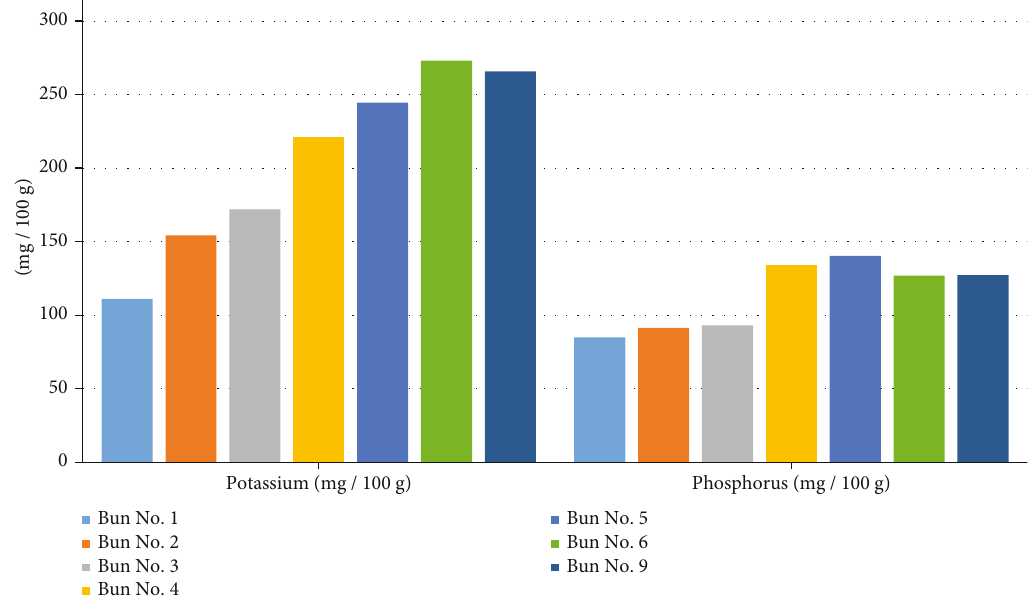
Figure 15: The content of potassium and phosphorus in the various bun formulations.